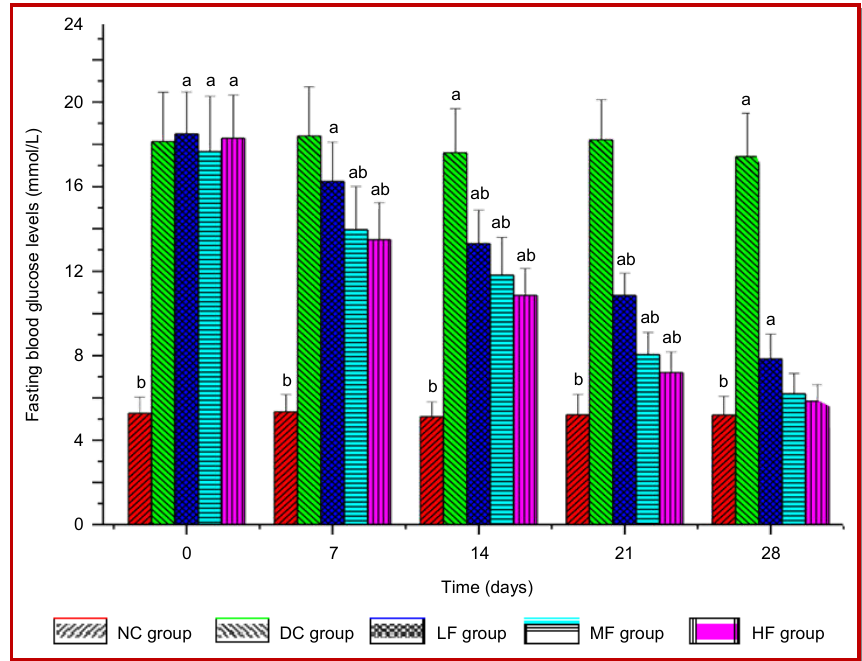
Figure 1: Effects of FTB on fasting blood glucose levels in mice. Data were presented as means ± SD. a p < 0.05 as compared with the NC group. b p<0.05 as compared with the DC